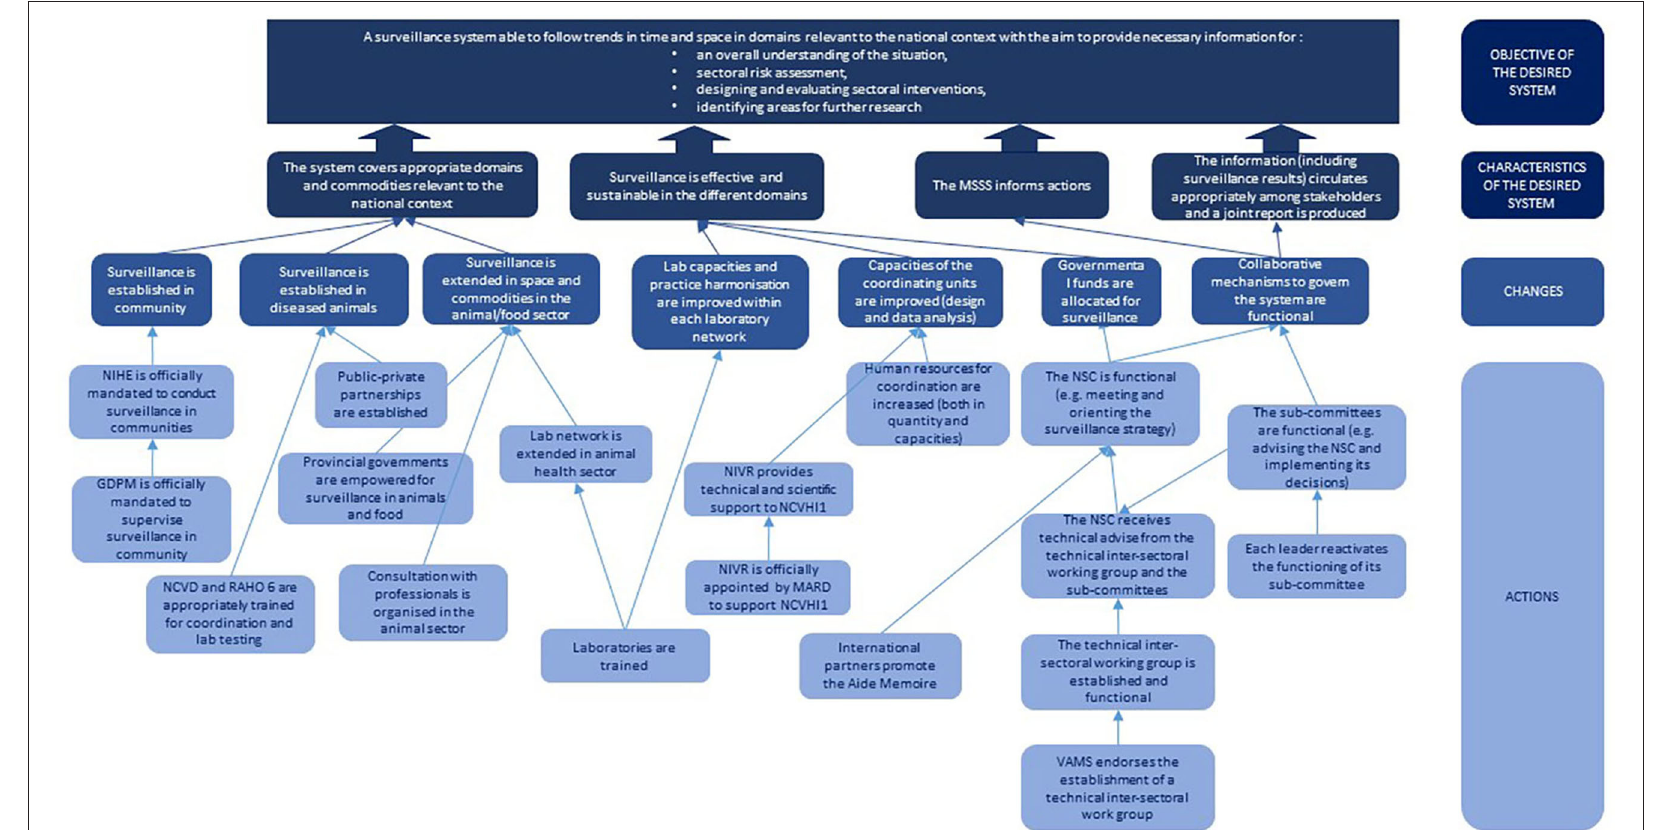
FIGURE 7 | The innovation pathway constructed by participants to the participatory process in Vietnam. GDPM, General department of preventive medicine; MARD Ministry of agriculture and rural development; NCVD, National center for veterinary diagnostic; NCVHI1, National center of veterinary hygiene 1; NIHE, National institute of hygiene and epidemiology; NIVR, National institute of veterinary research; NSC, National steering committee; RAHO 6, Regional animal health office 6; VAMS, Vietnam administration of medical